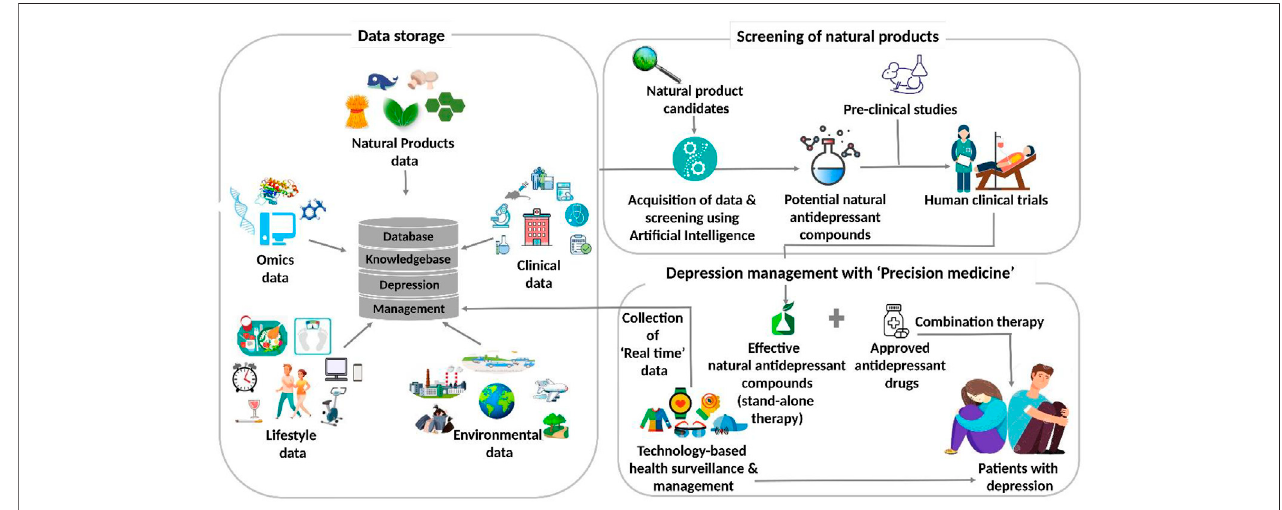
FIGURE 6 | The futuristic translational informatics-based model for depression management using natural antidepressants.